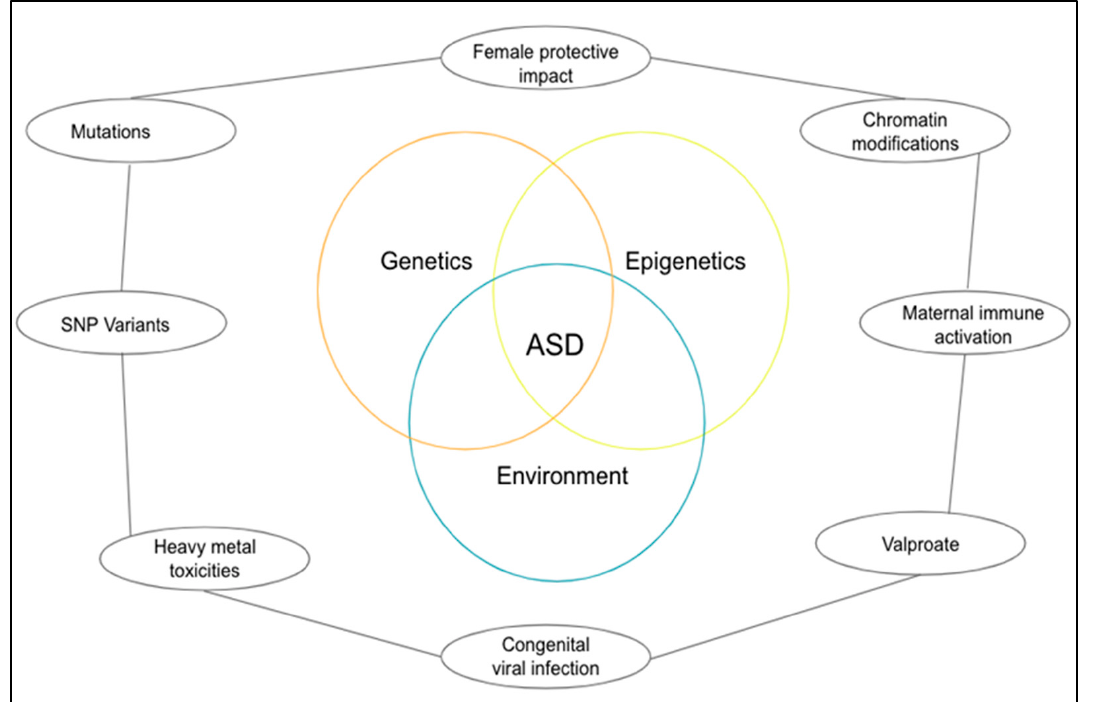
Figure 1. A diagrammatical representation of the pathogenesis of ASD.